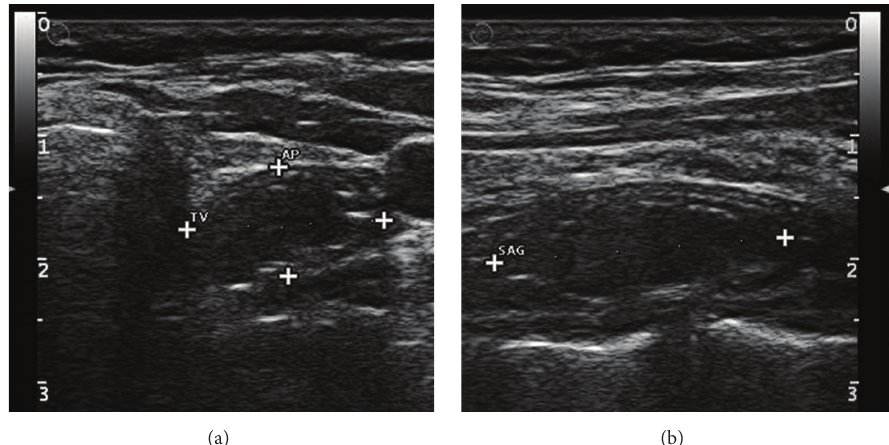
Figure 2: Transverse (a) and longitudinal (b) sonograms show a hypoechoic lesion with internal hyperechoic foci and hypoechoic